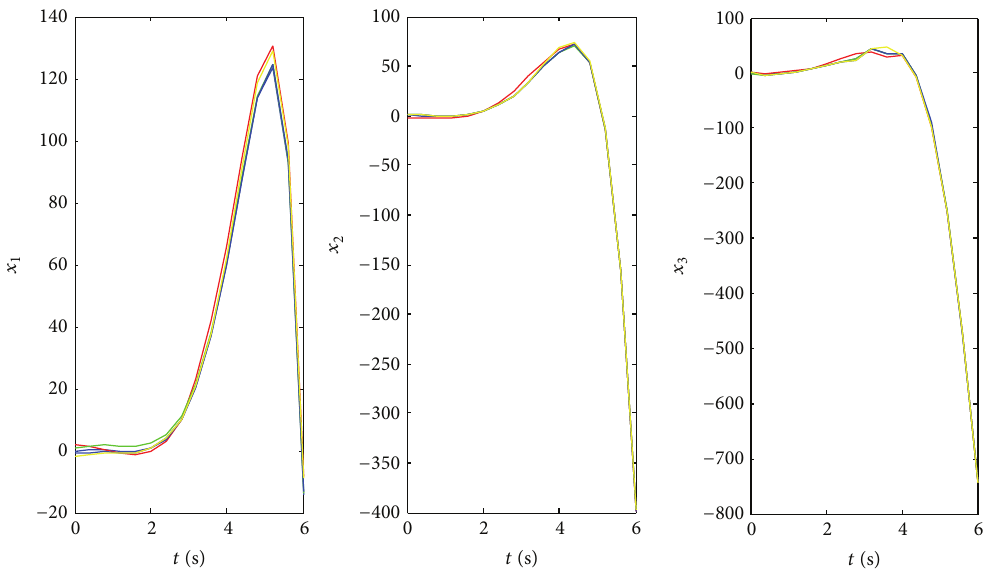
Figure 7: Trajectories of agents under complete broadcasting lossy